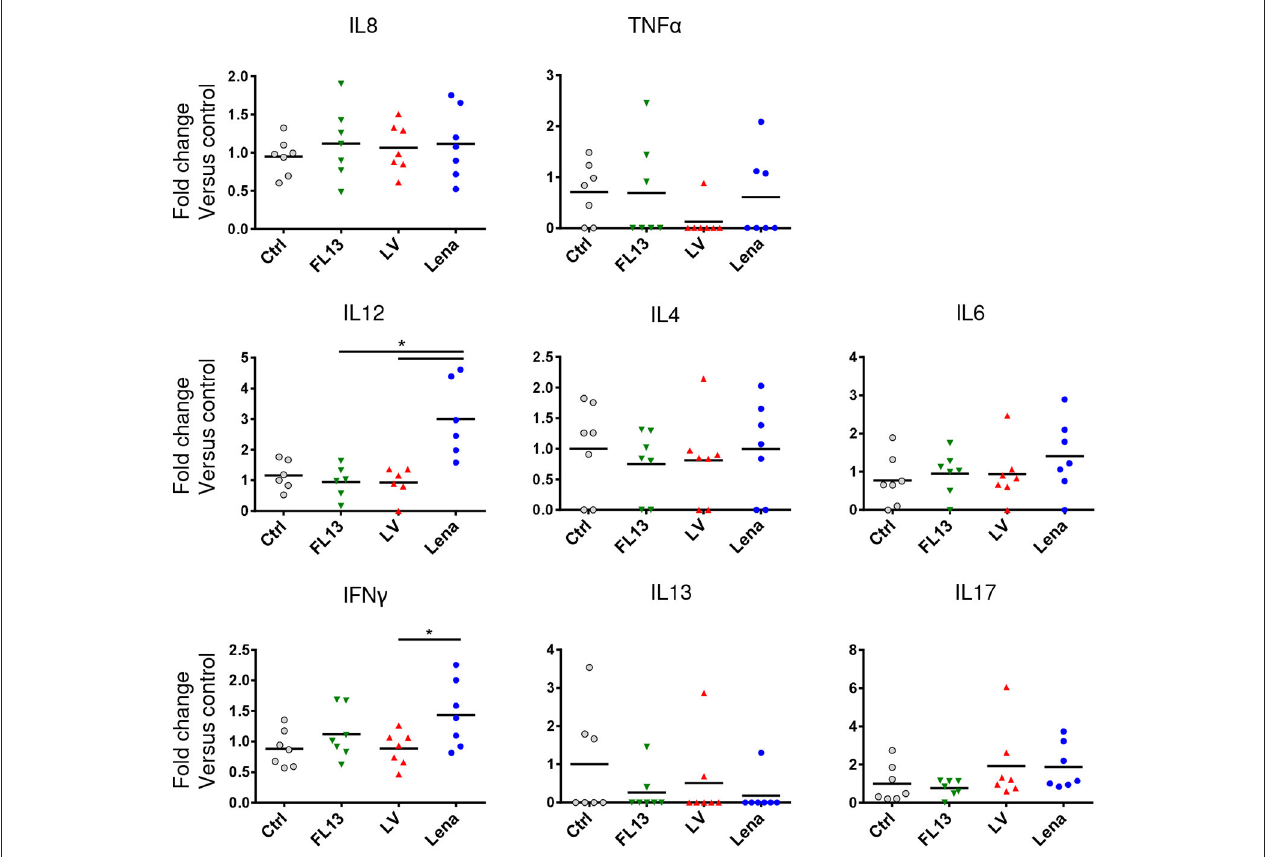
FIGURE 4 | MPC exposure to Lena virus induces IL12A and IFNg secretions. MPC enriched PAR were cultured for 24h at MOI 0.5 with FL13 (Green triangle), LV (Red triangle), and Lena (Blue circle) in complete RPMI. Supernatants were collected and analyzed by Cytokine Bead Assay (CBA). Data were normalized as fold change relative to control. The control samples mean has been calculated for each cytokine, then, each sample value, including the control sample values used for the reference mean calculation, is individually expressed as a percentage of this mean. Wilcoxon test was performed. * p < 0.05.